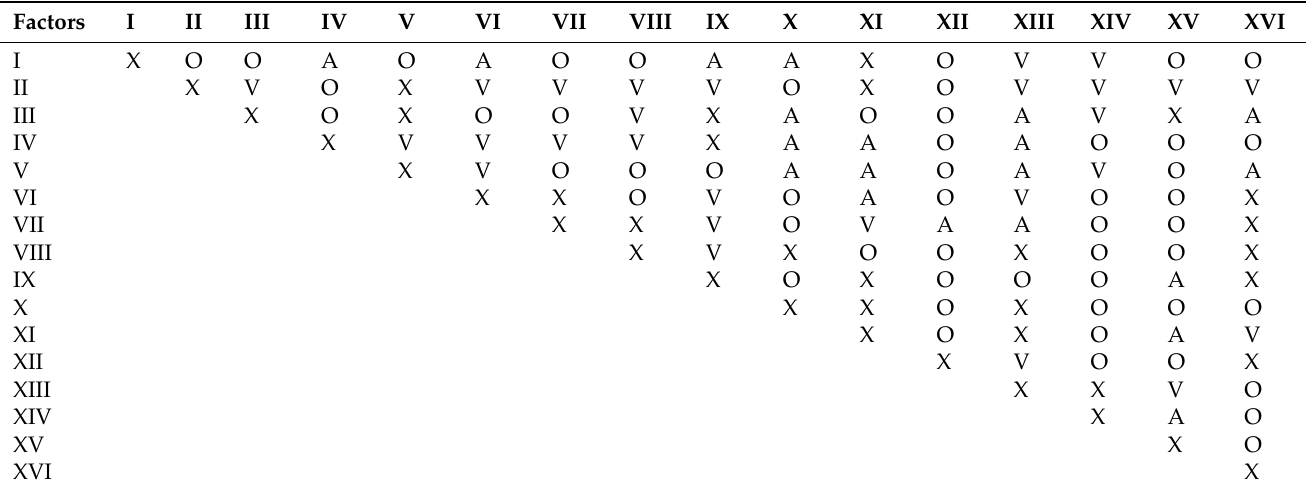
Table 2. SSIM for